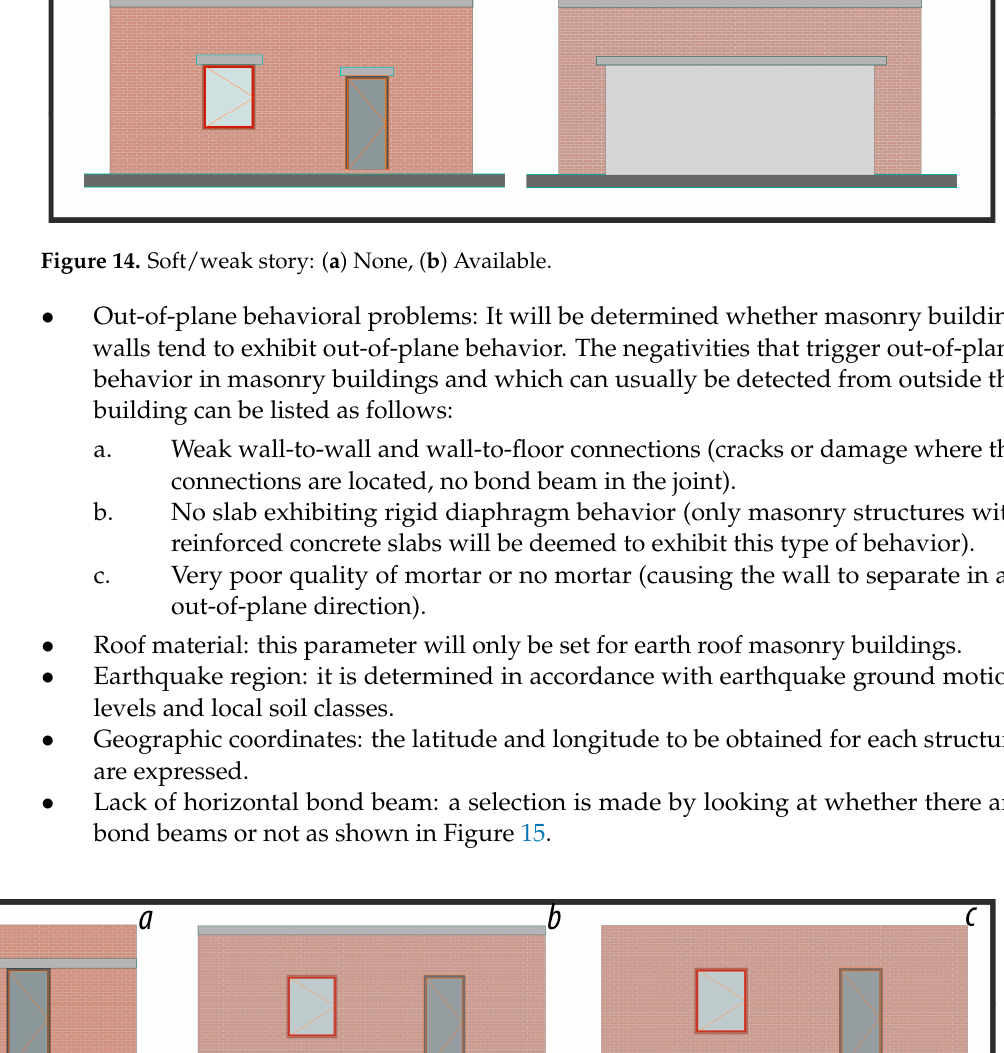
Figure 13. Differences between the floors according to the facade: ( a ) None, ( b ) Available, ( c ) Available.